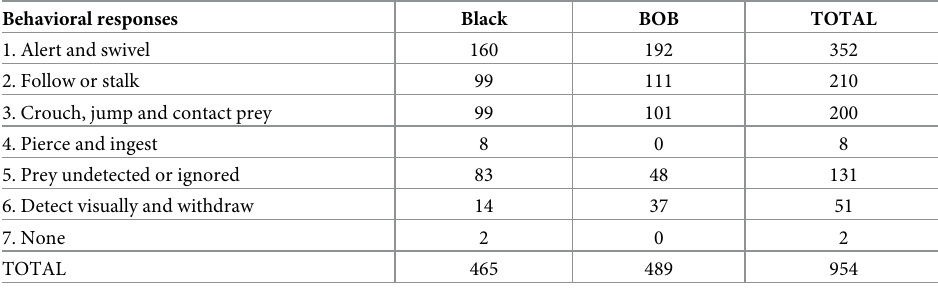
Table 1. L . jemineus individual behavioral responses. Behavioral responses